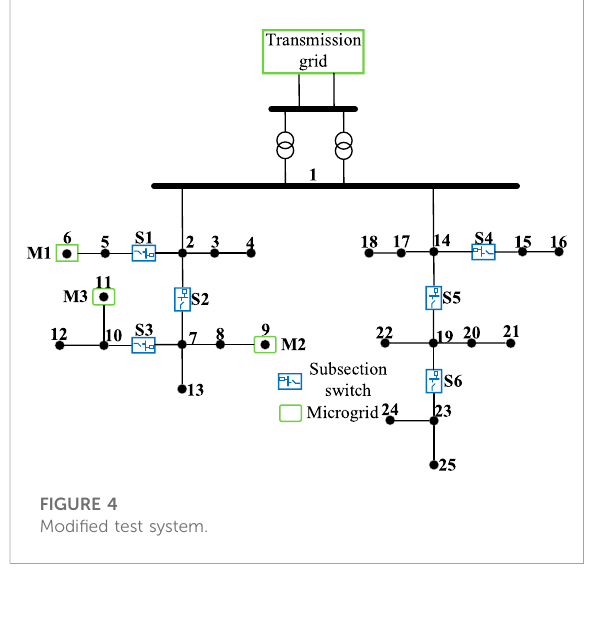
FIGURE 4 Modi fi ed test system.